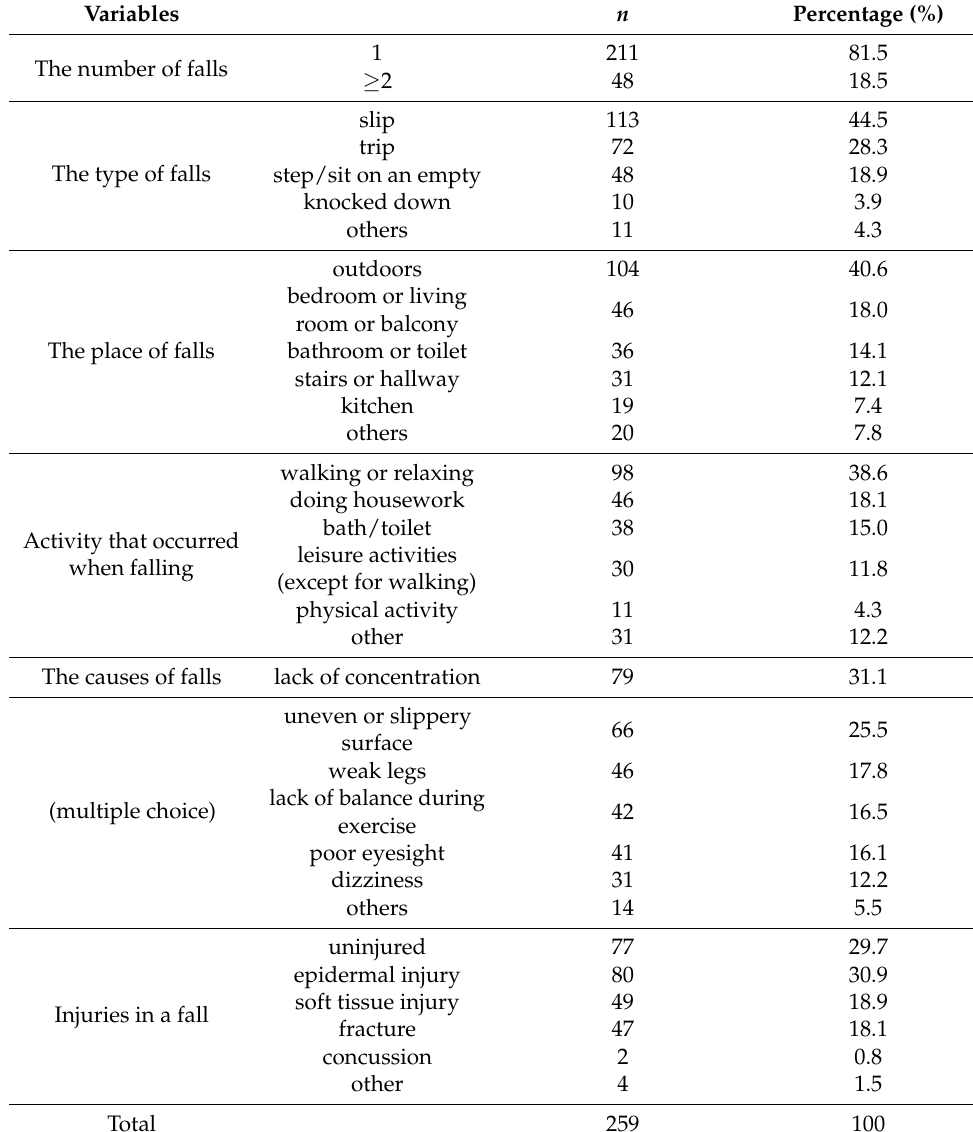
Table 3. Characteristics of falling behavior in the elderly aged 60 years and older ( n = 259).